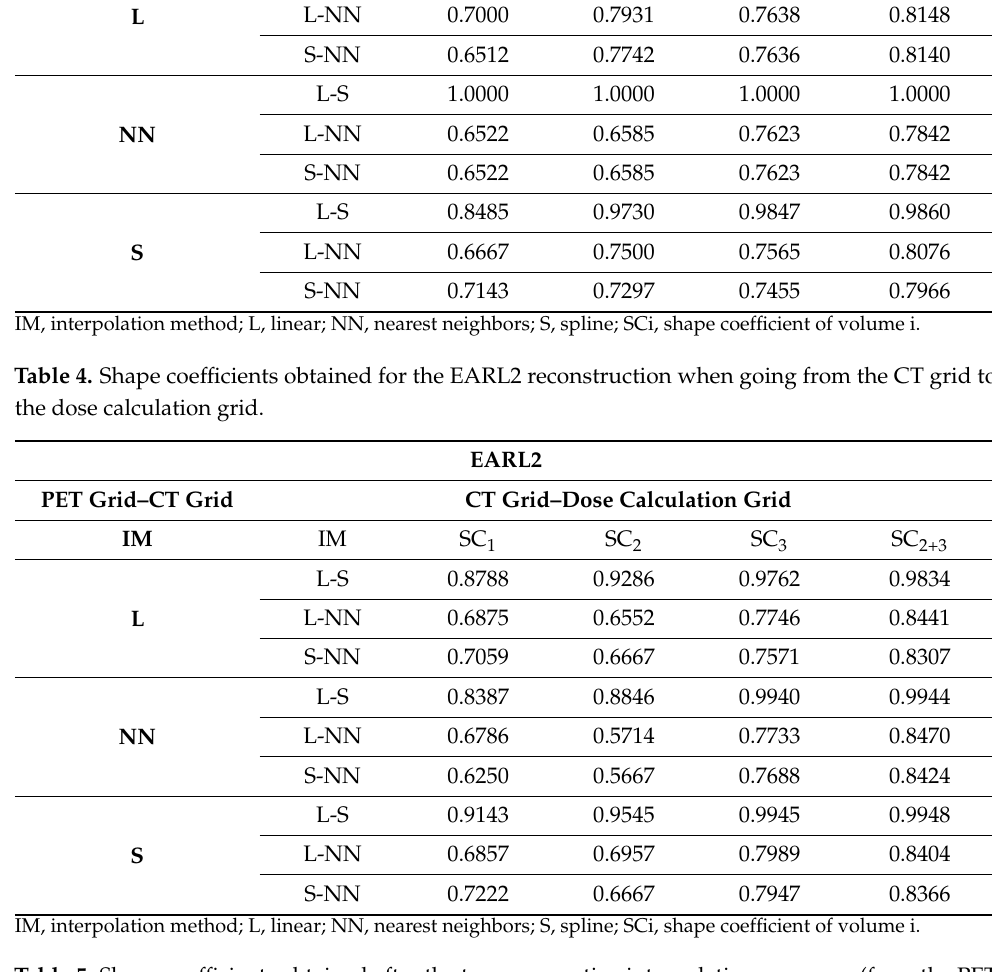
Table 5. Shape coefficients obtained after the two consecutive interpolation processes (from the PET grid to the CT grid, and from the CT grid to the dose calculation grid) for each image reconstruction followed in EARL1 and EARL2